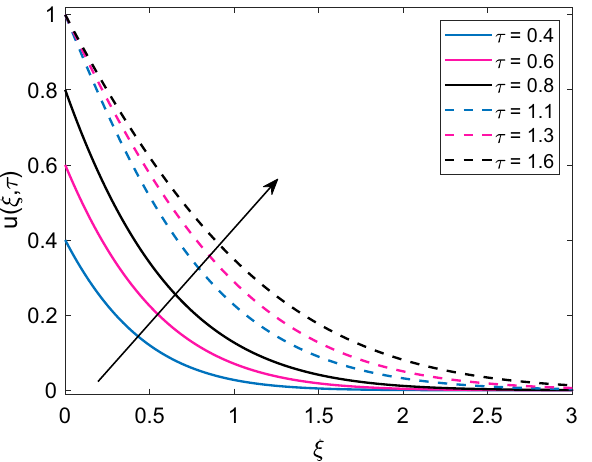
Figure 13. Velocity distribution [Eq. (39)] for various values of τ when M = 2.0 , K = 0.5 , Gr = 5.0 , Nr = 0.5 , φ = 0.1 and Q = 0.5 .